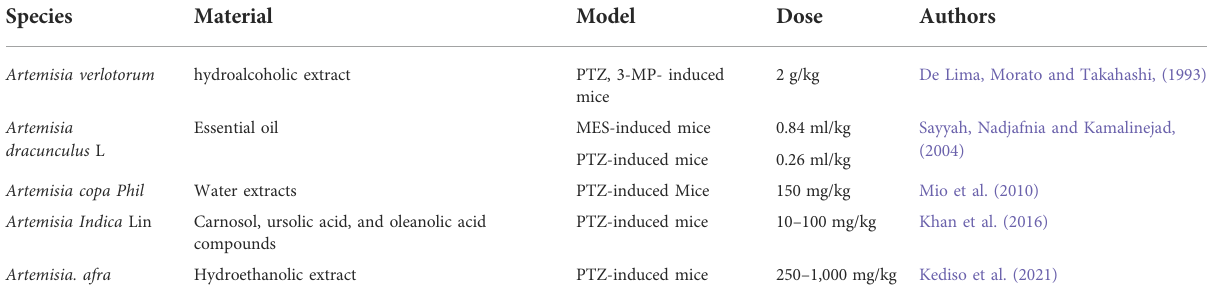
TABLE 1 Anticonvulsant activities of Artemisia species in vivo in animal models.